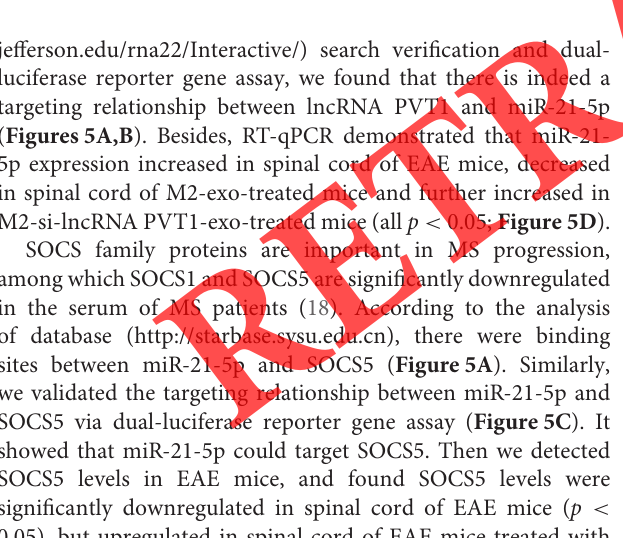
FIGURE 3 | LncRNA PVT1 enters EAE mice from M2-exos. (A) DiR labeled exosomes were traced in mice. It showed that exosomes mainly existed in liver and spleen 24h after they entered the mice. Fluorescence also appeared in spinal cord of EAE mice; (B,C) Relative PVT1 expression in spinal cord of EAE mice with different treatment detected by RT-qPCR. Compared with the blank group, *** p < 0.001; compared with the EAE group, ## p < 0.01, ### p < 0.001. Data in (B) are analyzed with one-way ANOVA, and Tukey’s multiple comparisons test was utilized for post hoc test. Data in (C) were analyzed by the t -test n =